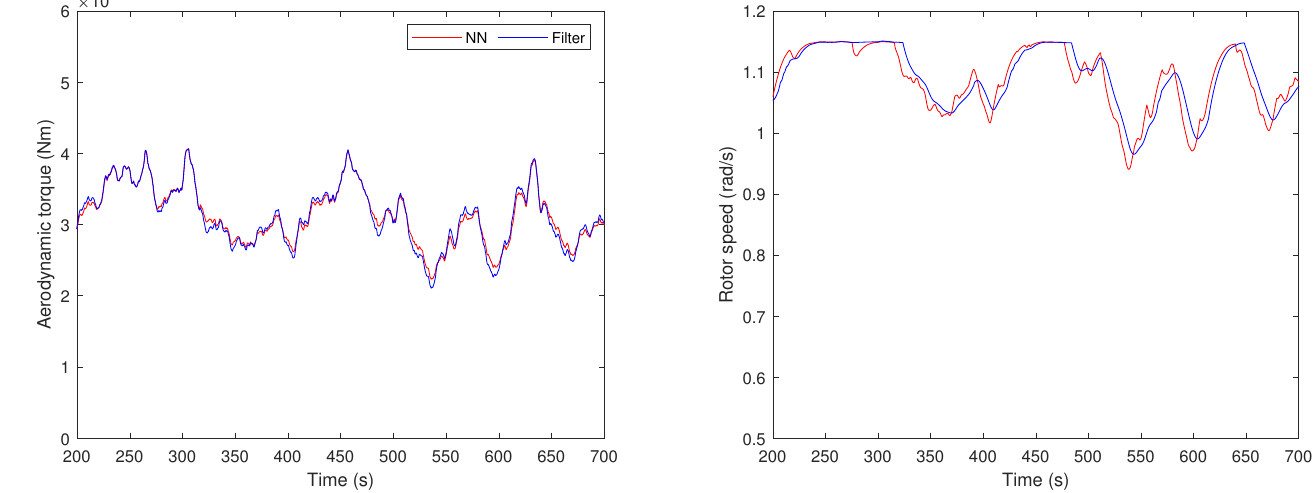
Figure 18. Output at a mean wind speed of 10 m/s (mode 3).